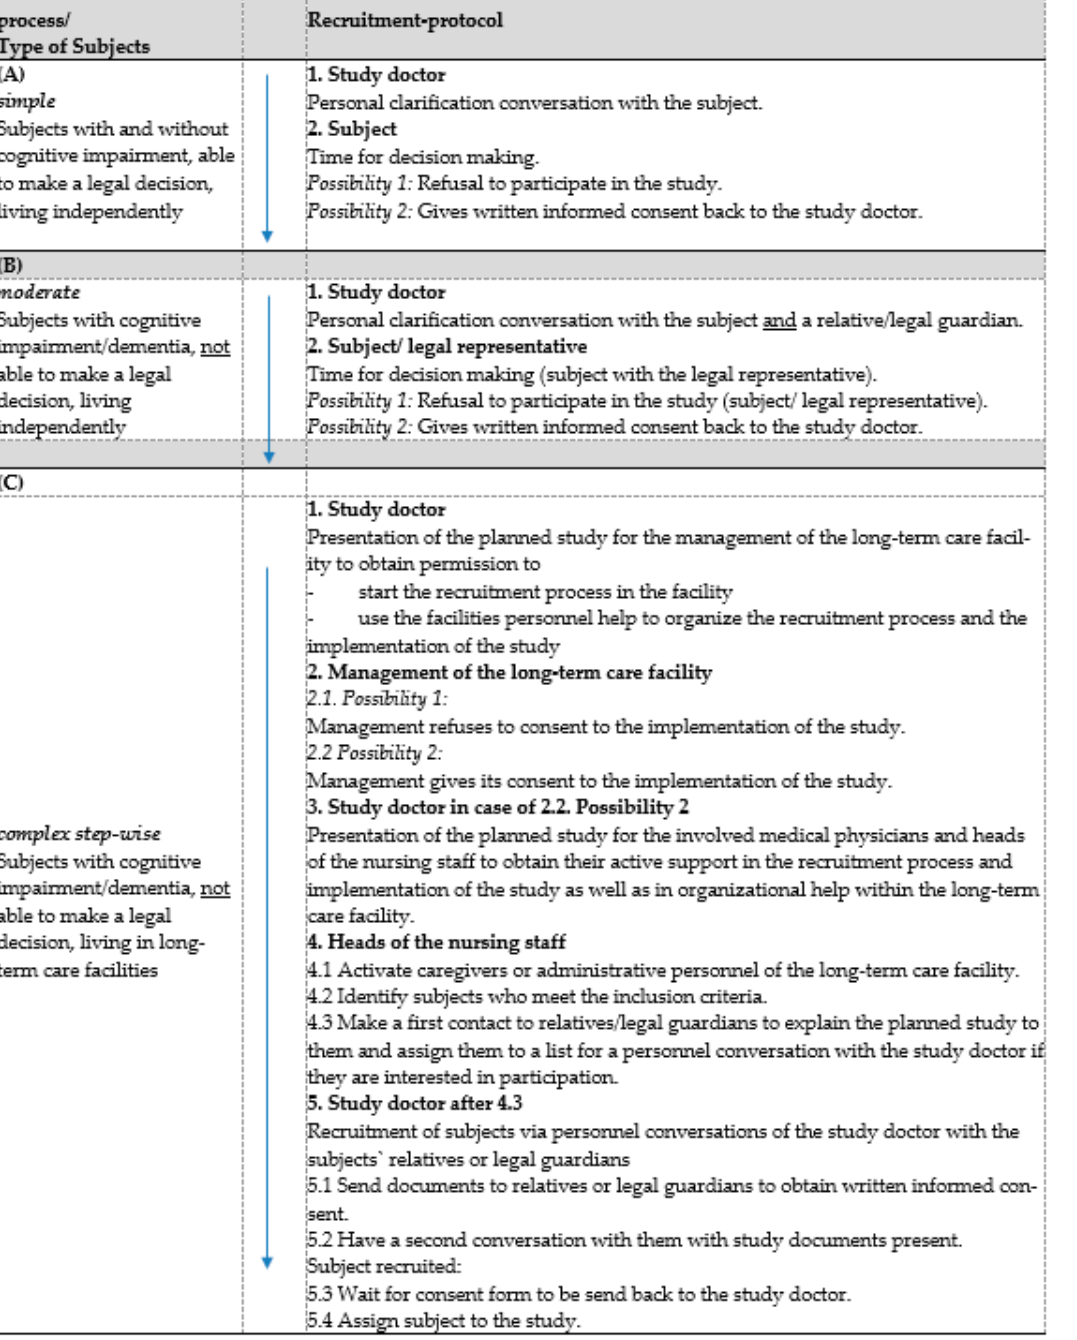
Figure 2. Recruitment process of study subjects depending on their cognitive condition, living situation and ability to obtain legal consent to study participation: simple, moderate or complex stepwise recruitment.